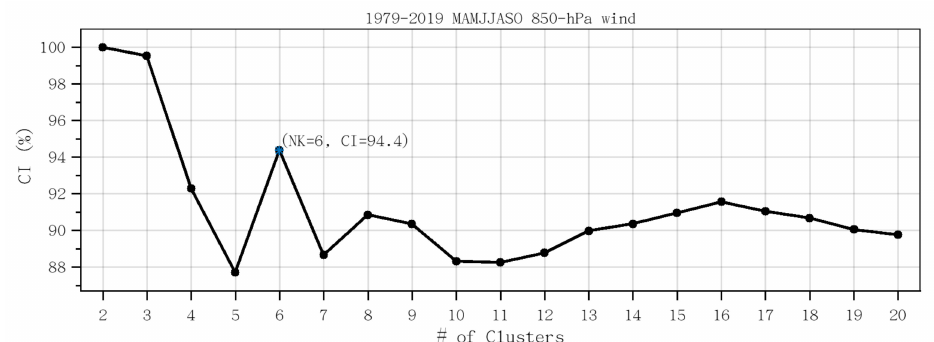
Figure 2. The classifiability index (CI) of the k-means clustering analysis using 850 hPa zonal and meridional wind component (u and v) in the Southeast U.S. and the surrounding region (100 ◦ W–65 ◦ W, 20 ◦ N–45 ◦ N) in March–October, 1979–2019; the optimum number for the k-means analysis is k =